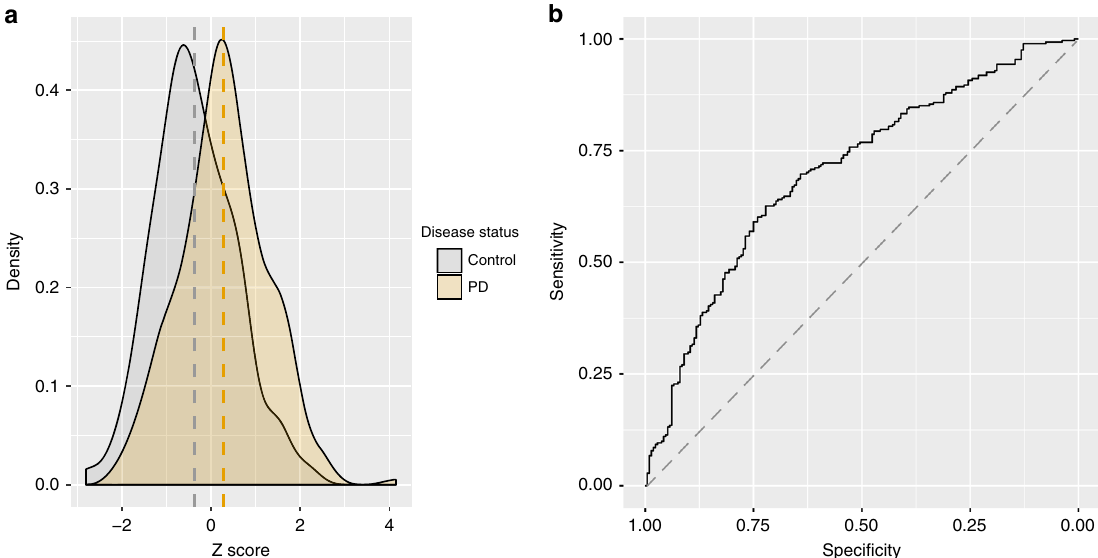
Fig. 4 DNA methylation-based classi fi cation of PD. a Density distribution of the SGPD-derived DNA methylation-based classi fi er in the PEG cohort. Orange and gray represent the distributions of the z-scaled classi fi er in PD cases and controls in the PEG cohort (respectively). b Area under the receiver operator characteristic curve (AUC) of the SGPD-based DNA methylation classi fi er in the PEG cohort (AUC = 0.70, 95% CI = 0.66 –